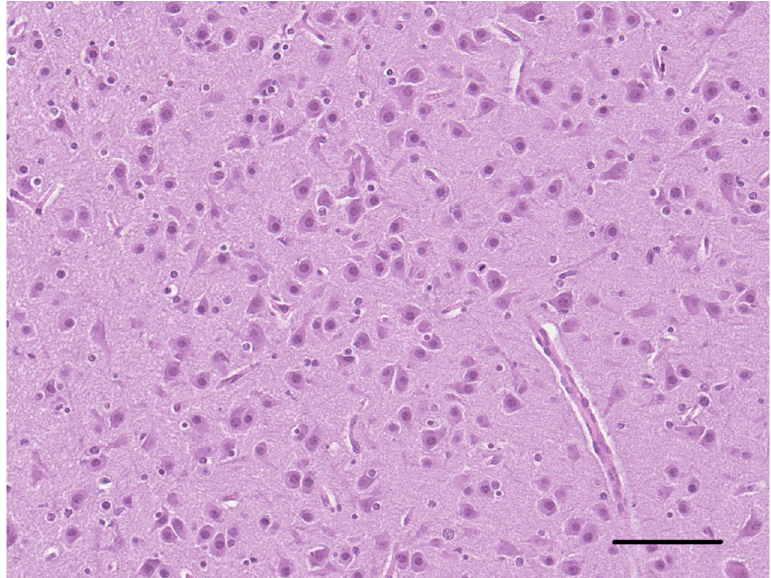
Figure 5. Cerebral cortex of dog 2. Neurons are haphazardly oriented and the distinction of the single cortical layers is not evident (HE, bar = 100 μ m).